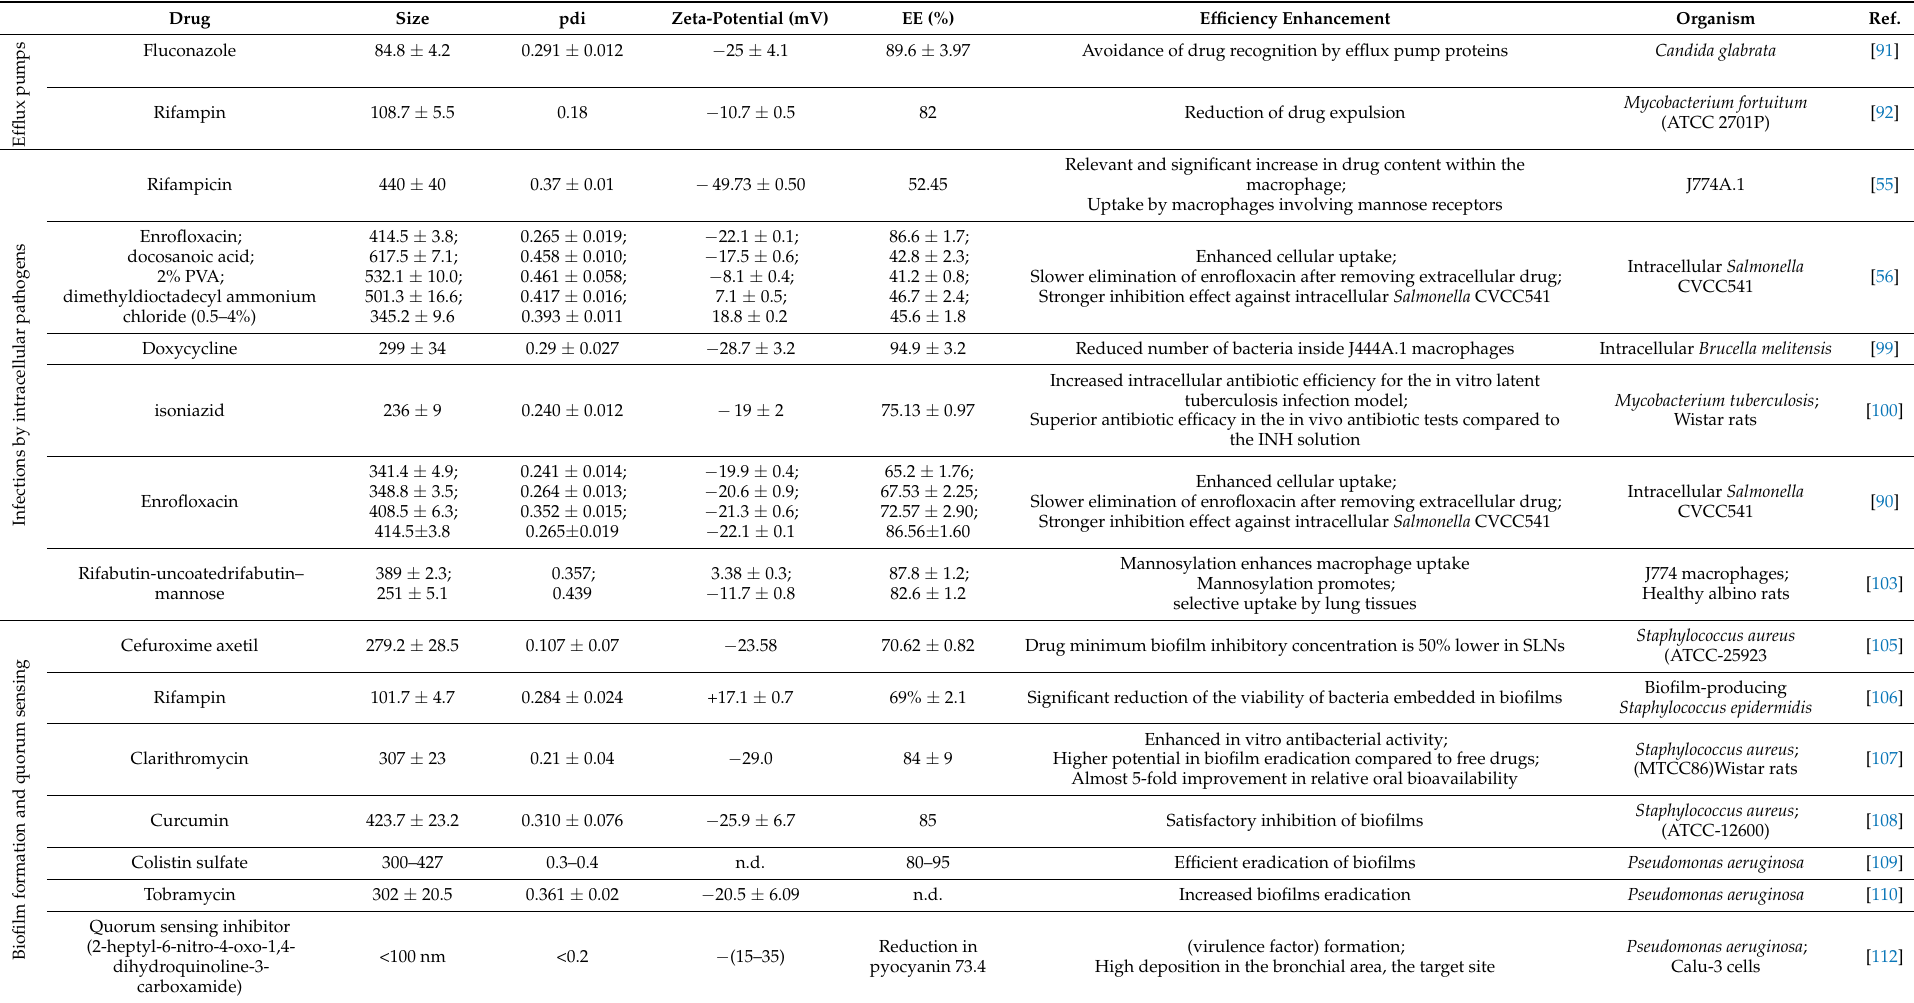
Table 1. Characteristics of SLNs formulations applied to reduce resistance